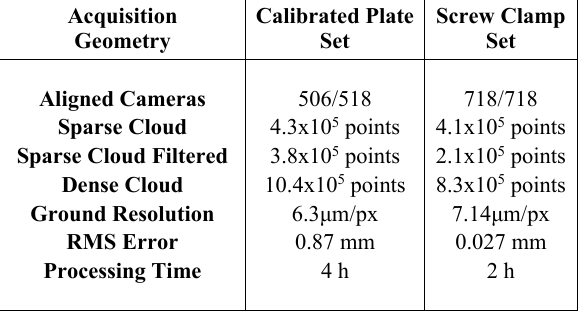
Table 1 . Survey data comparison.